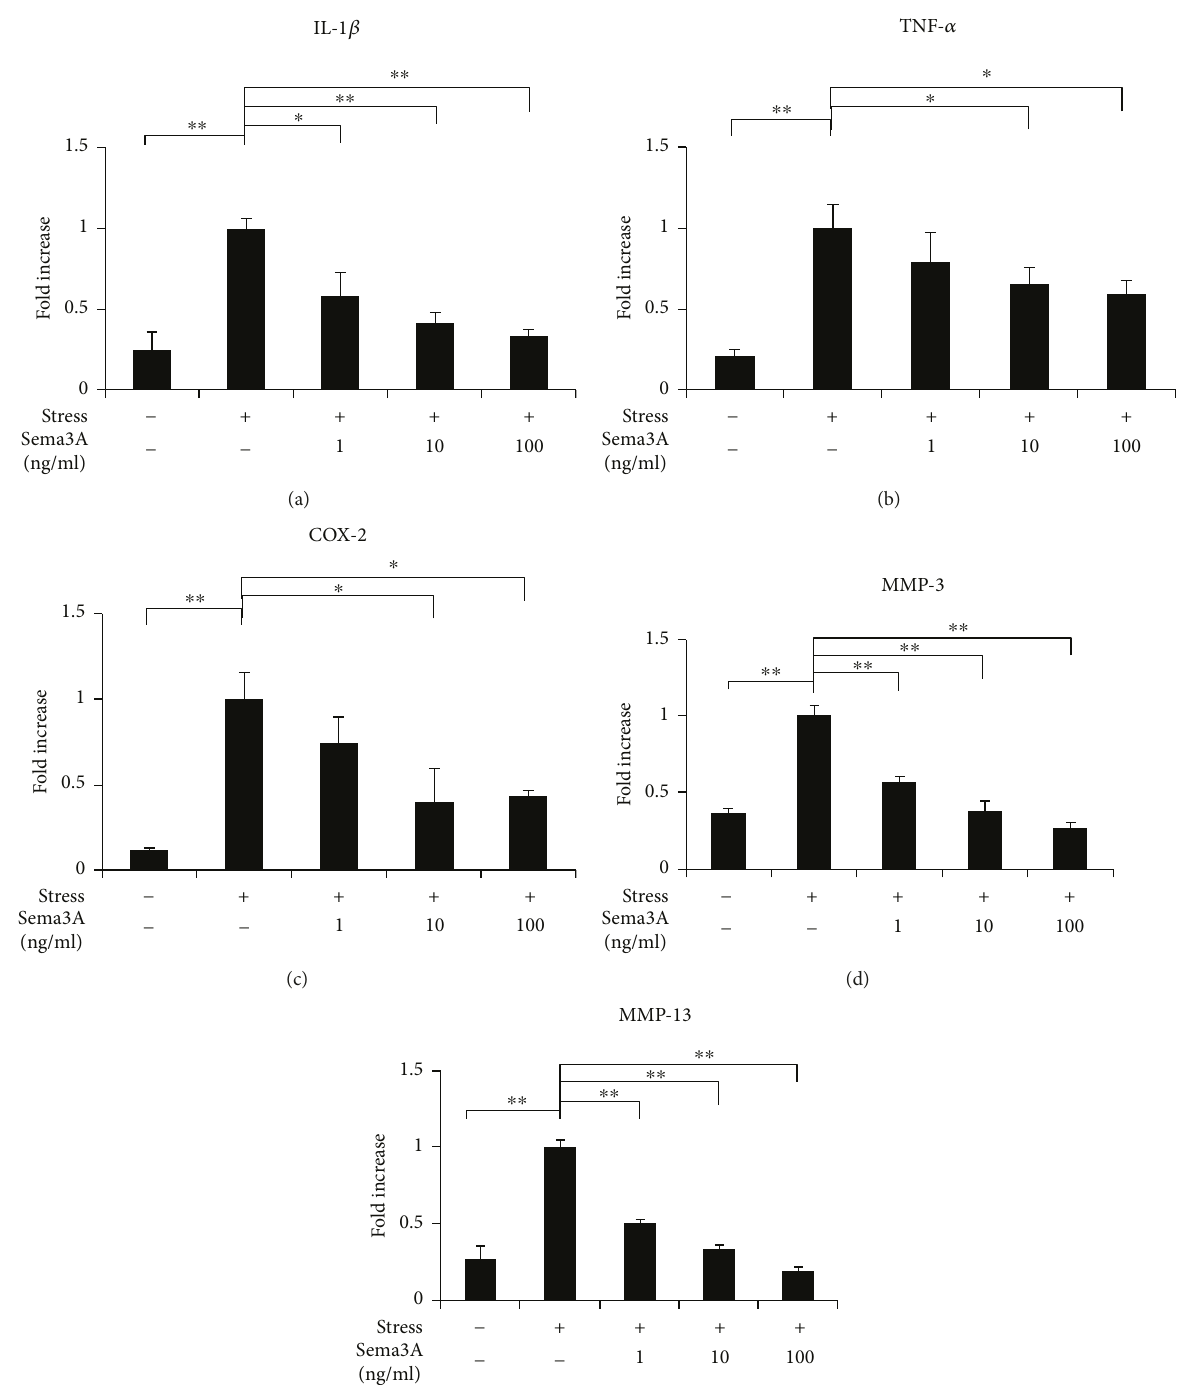
Figure 4: E ff ect of Sema3A on gene expression of in fl ammatory mediators under excessive mechanical stress. ATDC5 cells treated with various concentrations of Sema3A were subjected to excessive CTS for 3 h. Gene expression of IL-1 β , TNF- α , COX-2, MMP-3, and MMP- 13 was measured by qPCR (a – e). Data are expressed as mean ± SD, n = 3 . ∗ P < 0 05 , ∗∗ P < 0 01 compared to the group with CTS but without